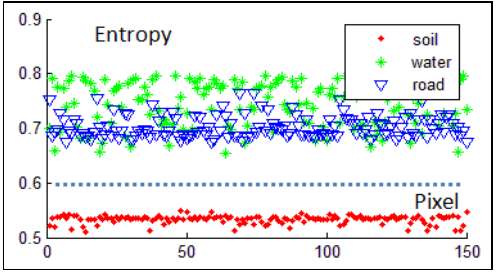
Figure 6. The entropy of 150 samples in the soil/road/water